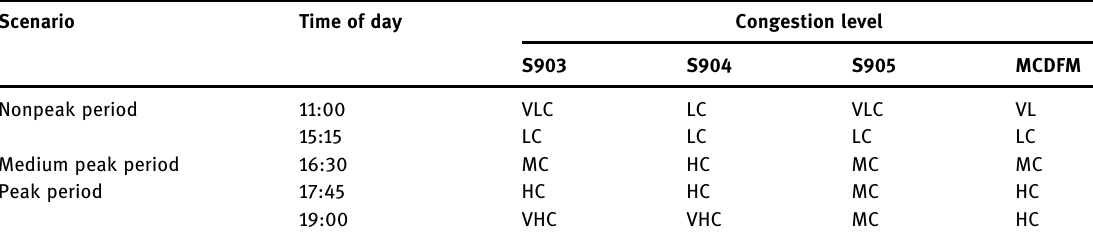
Table 7: The decisions of the DFMs at each intersection